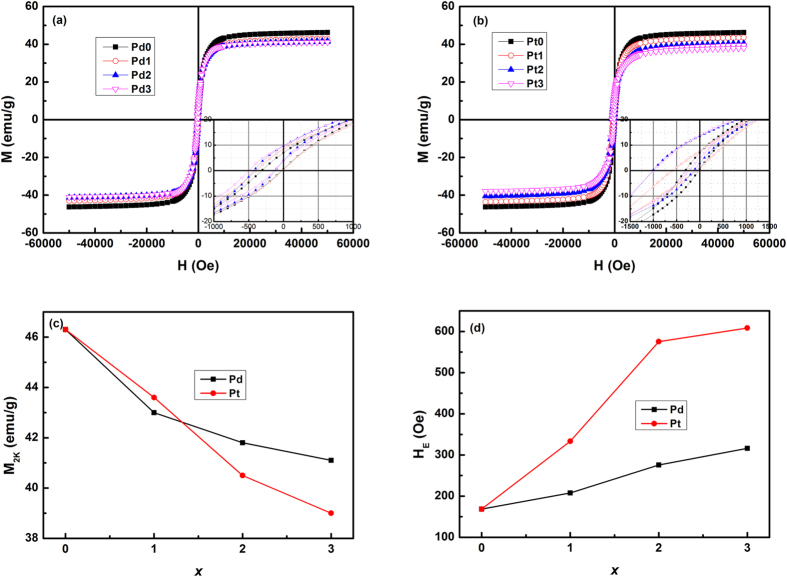
(a) M-H loops at 2 K after FC (HFC = 10 kOe) from 300 K for Ni50−xMn36Sn14Pdx (x = 0, 1, 2, 3) alloys; (b) M-H loops at 2 K after FC (HFC = 10 kOe) from 300 K for Ni50−xMn36Sn14Ptx (x = 0, 1, 2, 3) alloys; (c) The saturated magnetization at 2 K as a function of Pd(Pt) content; (d) HE at 2 K after FC (HFC = 10 kOe) from 300 K as a function of Pd(Pt) content.